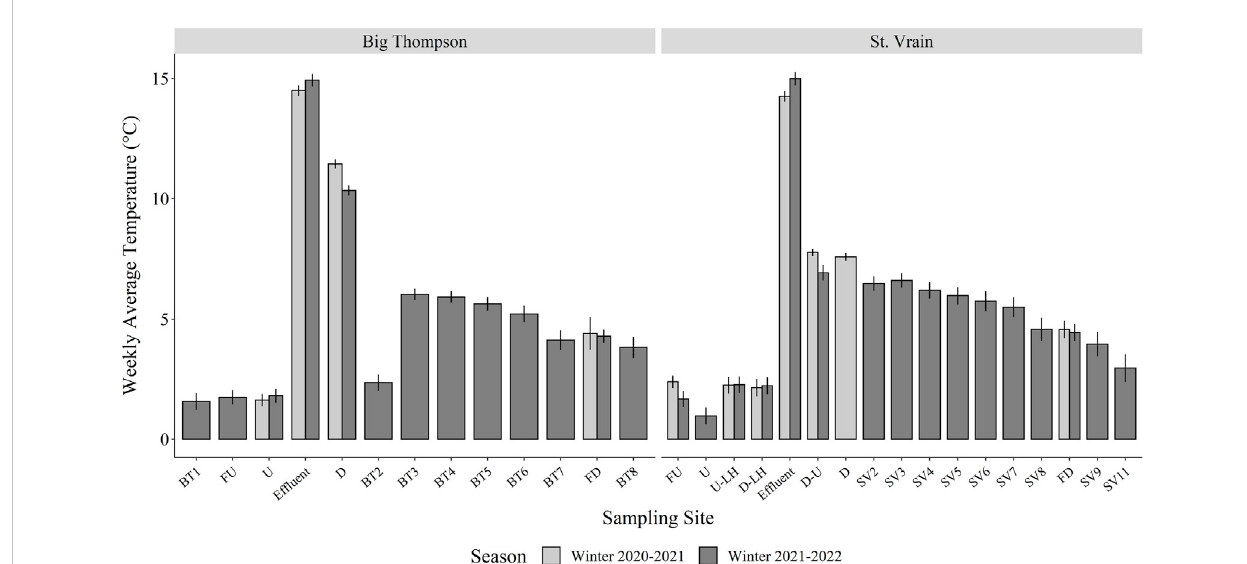
Average water temperatures at each temperature monitoring site for winter 2020 – 2021 and 2021 – 2022. BT1 – BT8 and SV2 – SV11 were deployed for a month in 2022 to collect more fi ne-scale spatial temperature data while other loggers were deployed prior to winter 2020 – 2021. D – SV was lost during the spring of 2021 and not replaced for the following winter. Sites are organized from upstream to downstream from left to right for each